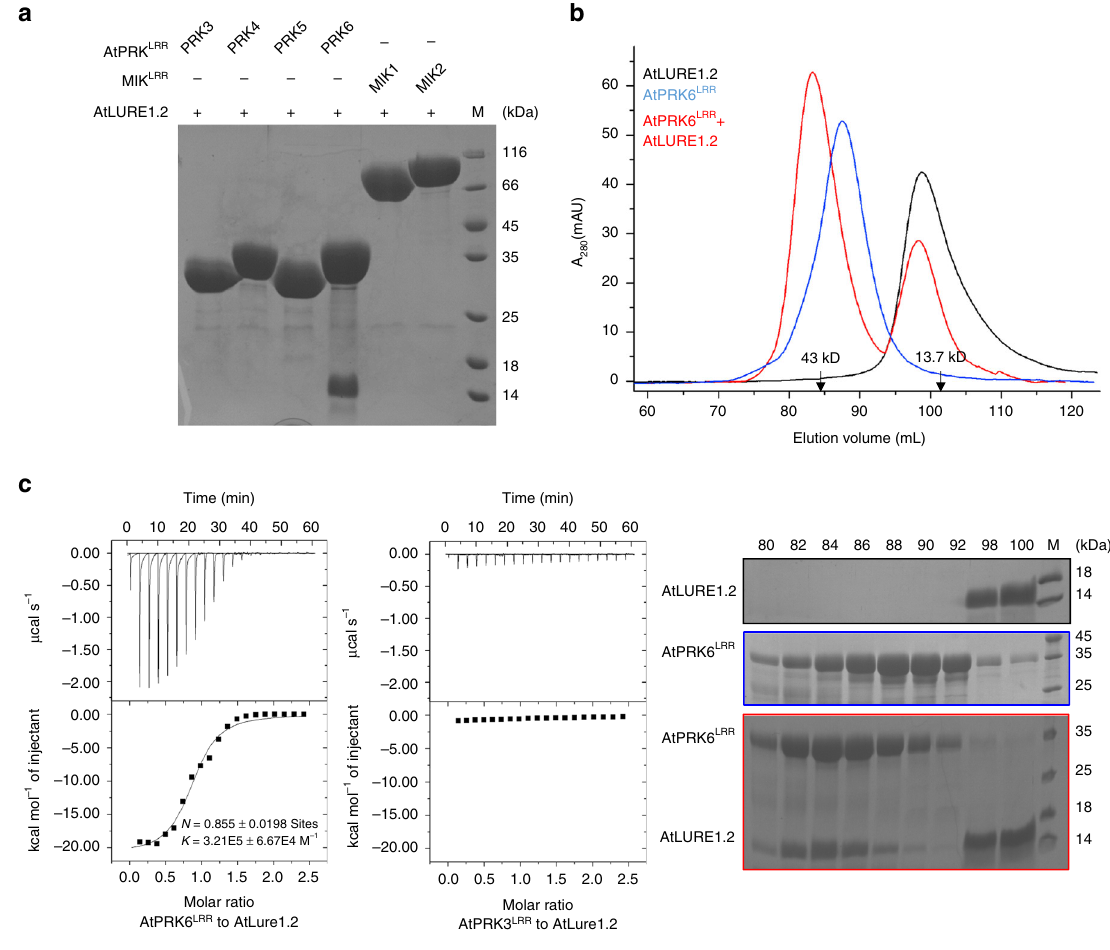
Fig. 1 AtPRK6 LRR speci fi cally interacts with AtLURE1.2 in vitro. a AtLURE1.2 interacts with AtPRK6 LRR in a pull-down assay. The puri fi ed AtPRK LRR and MIK1 LRR , MIK2 LRR proteins with 6 × His at the C-terminus bound to Ni-NTA were individually incubated with an excess of AtLURE1.2 protein. After extensive washing, the bound proteins were eluted and visualized by Coomassie blue staining following by SDS-PAGE. b AtLURE1.2 binding does not alter the monomeric state of AtPRK6 LRR in solution. Upper panel: gel fi ltration pro fi les of AtPRK6 LRR , AtLURE1.2, and AtPRK6 LRR -AtLURE1.2 complex. The black arrows indicate the molecular weights around the AtPRK6 LRR -AtLURE1.2 complex and AtLURE1.2. A 280 (mAU), micro-ultraviolet absorbance at the wavelength of 280 nm. Lower panel: coomassie blue staining of the peak fractions shown on the top following SDS-PAGE. M, molecular weight ladder (kDa). Numbers on top of SDS-PAGE panel indicate elution volumes. c Measurement of the binding af fi nity between AtPRK6 LRR and AtLURE1.2 by ITC. Left upper panel: twenty injections of AtLURE1.2 solution were titrated into AtPRK6 LRR solution in the ITC cell. The area of each injection peak corresponds to the total heat released for that injection. Left lower panel: the binding isotherm for AtPRK6 LRR -AtLURE1.2 interaction. The integrated heat is plotted against the molar ratio between AtLURE1.2 and AtPRK6 LRR . Data fi tting revealed a binding af fi nity of about 3.1 μ M. Right panel: binding af fi nity between AtPRK3 LRR and AtLURE1.2 by